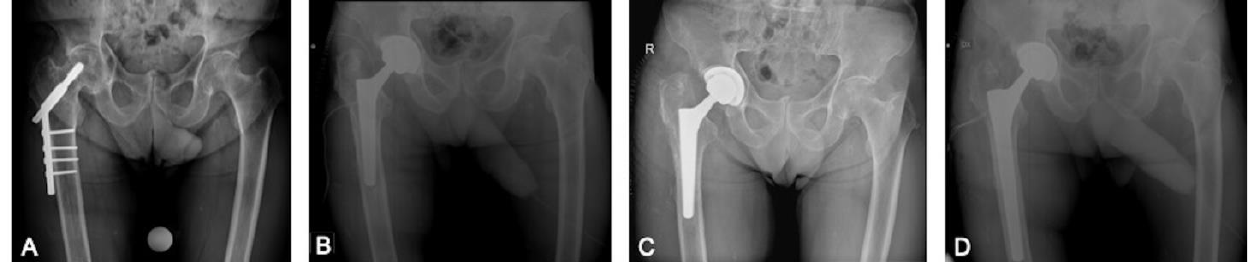
Figure 1. ( A ) Left pertrochanteric hip fracture treated with proximal femoral nail. S means left. ( B ) Fracture healed with varus and torsional deformity. ( C ) Left uncemented total hip arthroplasty with long revision conical stem.